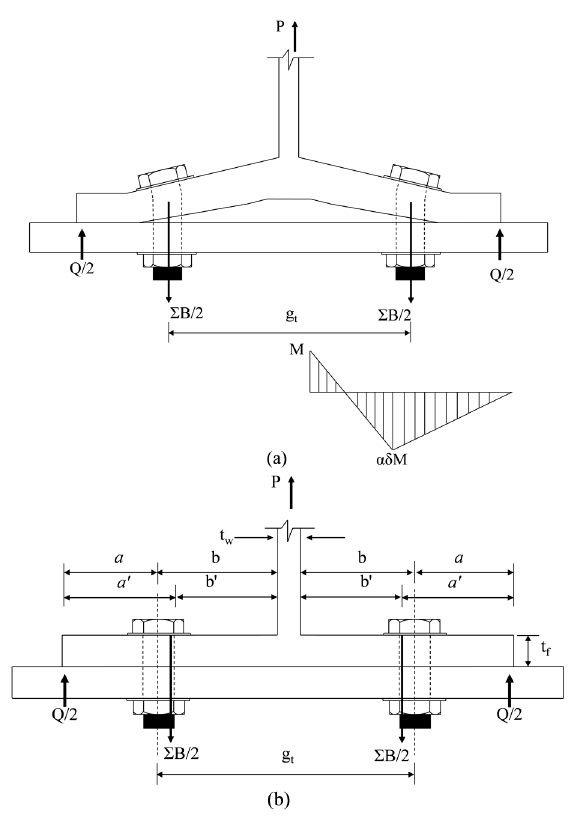
Figure 3. Typical prying action mechanism: ( a ) Prying action mechanism; ( b ) geometric definition. Metals 2017 , 7 , 386